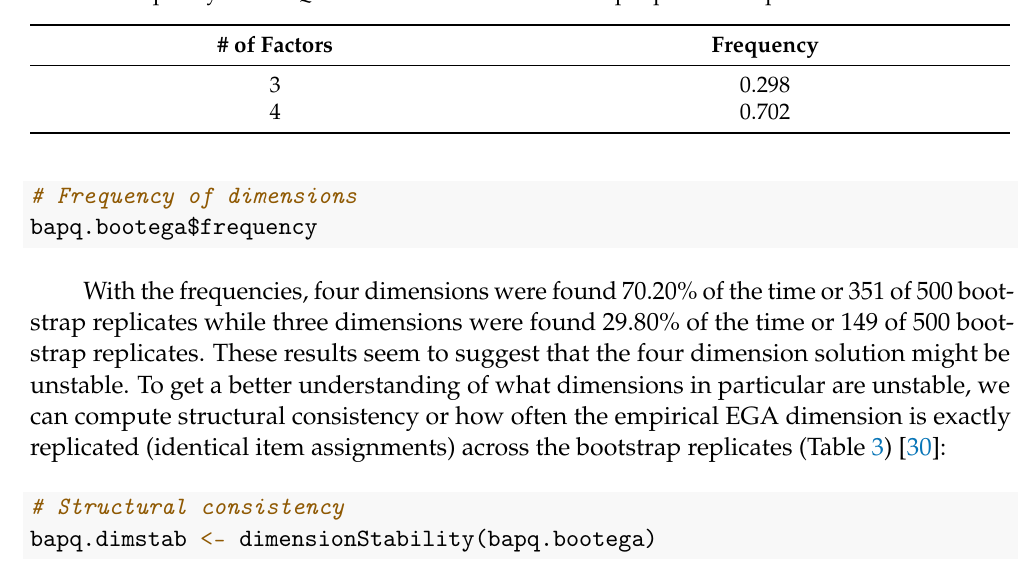
Table 2. Frequency of BAPQ dimensions across all bootstrap replicate